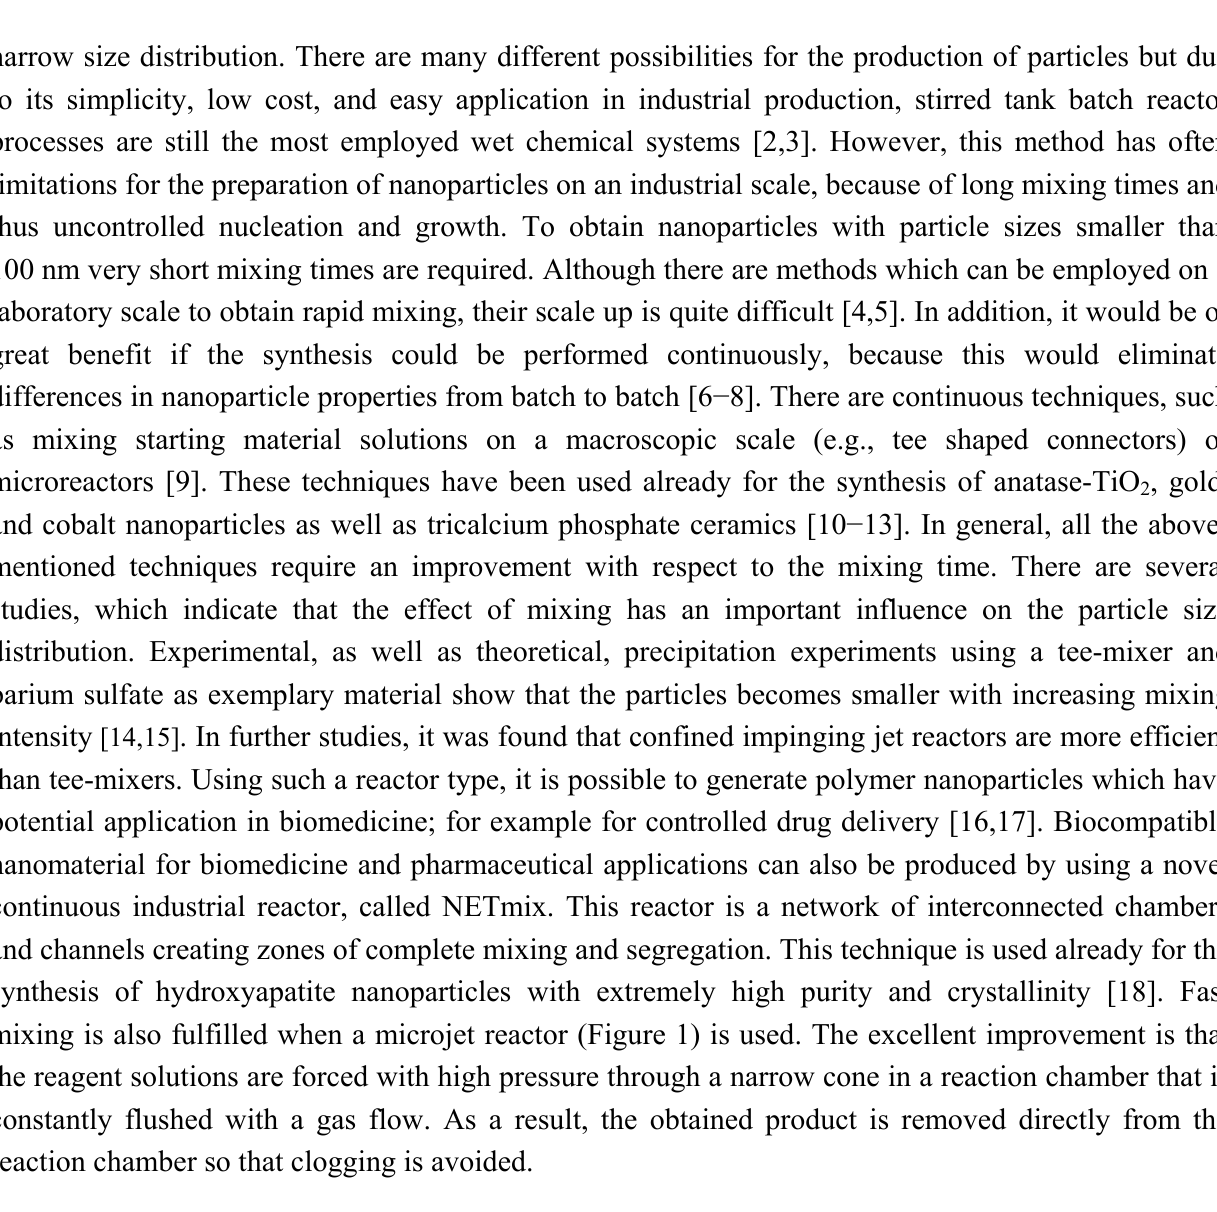
Figure 1. Schematic set-up of the microjet